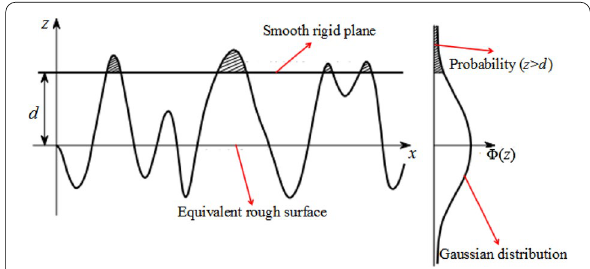
Fig. 6 Normal contact between two rough surfaces